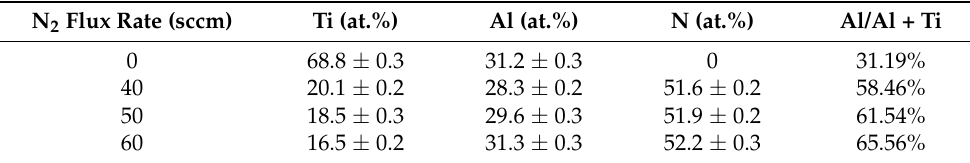
Table 3. Chemical composition tested by the EDS of TiAlN coatings. N 2 Flux Rate (sccm) Ti (at.%) Al (at.%) N